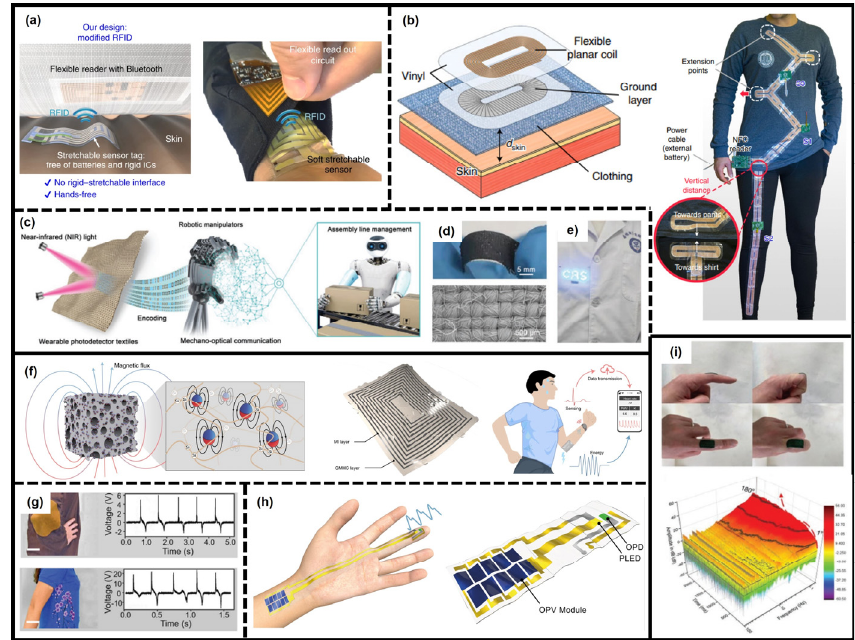
Figure 5. The novel data communication system, energy supply system, and data analysis system in wearable systems. ( a ) Schematic illustration and photograph of a bodyNET sensor system. Re- produced with permission from ref. [40] . Copyright 2019 Nature Publishing Group. ( b ) Schematic illustration of a wearable NFC resonator unit ( left ) and photograph of NFC network integrated on shirt and pants. Reproduced with permission from ref. [42] . Copyright 2021 Nature Publishing Group. ( c ) Schematic illustration of a light–machine interface platform. ( d ) Optical image of wearable photodetector ( top ) and SEM image of Te@TeSe assembled with carbon fibre fabric textile and Ag nanowires ( bottom ). ( e ) Optical image of wearable photodetector textile on clothes. Reproduced with permission from ref. [183]. Copyright 2021 Wiley-VCH. ( f ) Schematic illustration of a magnetoelastic system and its application in health monitoring. Reproduced with permission from ref. [184]. Copy- right 2021 Nature Publishing Group. ( g ) A wearable TENG biomechanical energy-harvesting system. Reproduced with permission from ref. [185]. Copyright 2019 Wiley-VCH. ( h ) Schematic diagram of a self-powered photoplethysmograpm sensor on human hands. Reproduced with permission from ref. [186]. Copyright 2021 Nature Publishing Group. ( i ) Three-dimensional surface plot for continuous angular movement of finger. Reproduced with permission from ref. [187].